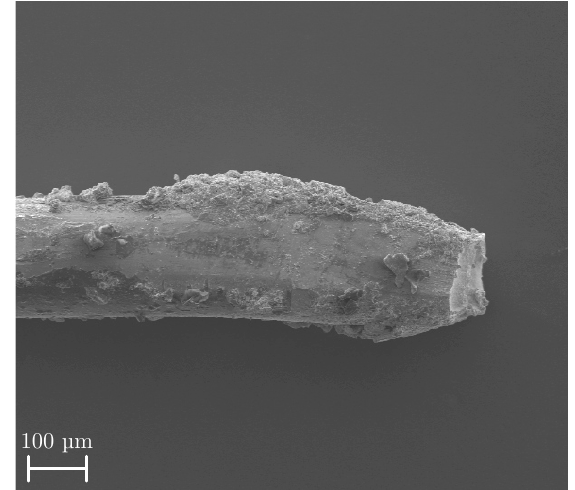
Figure 9. Ruptured fibre (steel fibre type 1) with adhering matrix particles